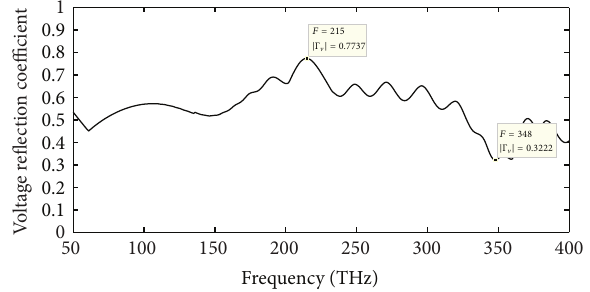
Figure 9: Voltage reflection coefficient |Γ 𝑉 | near dipole of nanocir- cuit with parameters ℎ = 210 nm, 𝐿 = 1200 nm, 𝑎 𝐿 = 10 nm, = 10 nm, 𝑑 = 40 nm, 𝑁 𝑎 ℎ = 21 nm, and 𝑁 = 102 . Δ𝐿 ℎ